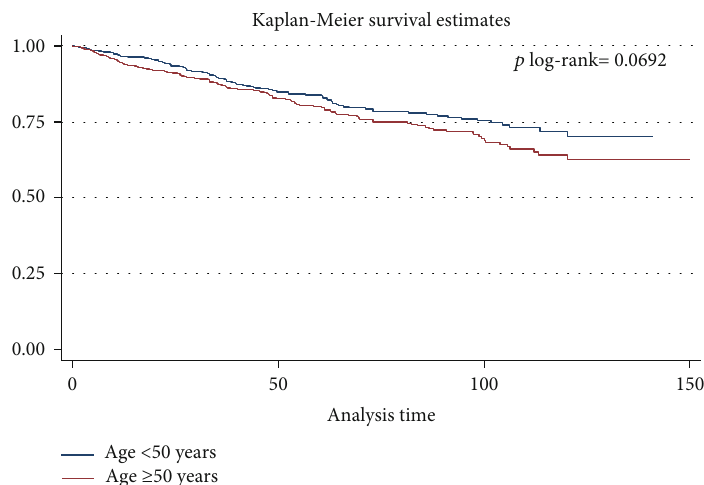
Figure 1: Kaplan-Meier survival curve, results for the test of equality of breast cancer-speci fi c survival functions for the di ff erent variables in Northwest of Iran, between 2007 and 2016 in both sexes (a) age